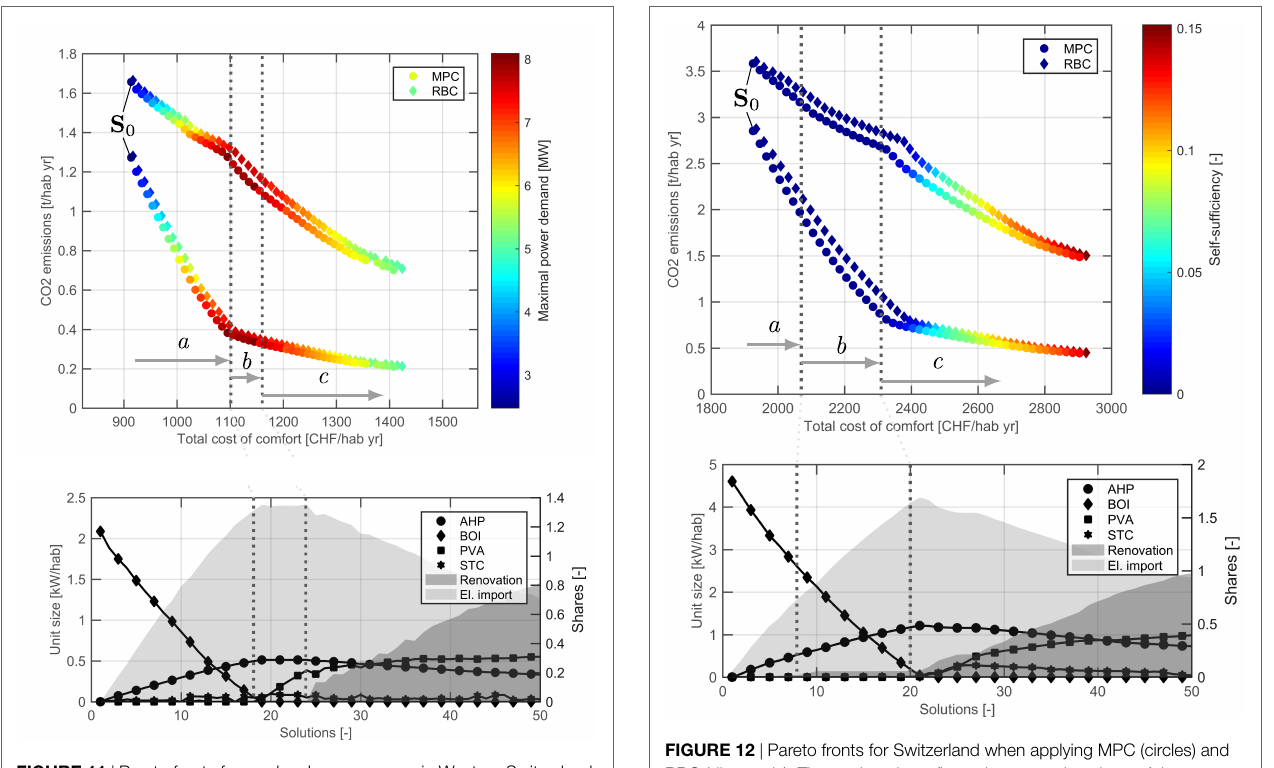
FIGURE 11 | Pareto fronts for a sub-urban commune in Western Switzerland when applying MPC (circles) and RBC (diamonds).